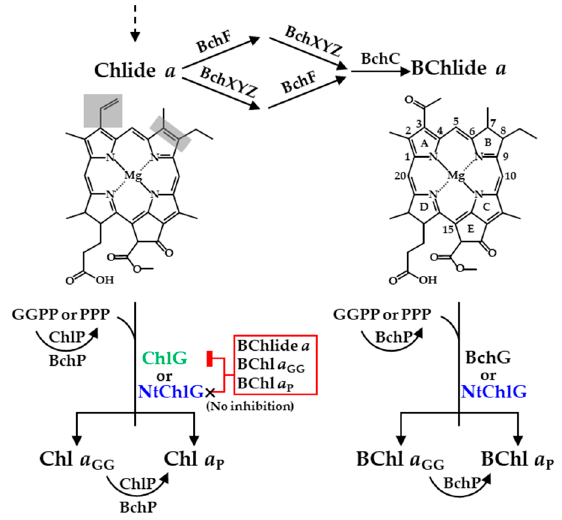
Figure 1. Chl a and BChl a biosynthesis in R. sphaeroides . Chlide a is metabolized by BchF and BchXYZ, and subsequently by BchC to form BChlide a . BChl a GG is synthesized via the ping-pong mode by BchG using GGPP and BChlide a as the first and second substrates, respectively. The GG group of BChl a GG is then reduced by BchP to yield BChl a P . Alternatively, PPP is first formed from GGPP by BchP and subsequently used as a substrate by BchG to produce BChl a P . Similarly, Chl a GG /Chl a P are synthesized by ChlG/ChlP. ChlP activity can be substituted by BchP [8] . Generally, ChlG would be inhibited by BChlide a , BChl a GG , and BChl a P (bacteriochlorin) (red box). Similarly, BchG would be inhibited by Chlide a , Chl a GG , and Chl a P (collectively called chlorin). However, this study focused on the analysis of recombinant R. sphaeroides synthesizing more BChl a than Chl a ; therefore, BchG inhibition by chlorin was negligible. Nicotiana tabacum ChlG (NtChlG), which is resistant to bacteriochlorin inhibition, was used to produce Chl a P together with BChl a P in R. sphaeroides . Carbon numbers and ring designations are illustrated in the BChlide a structure. Differences between Chlide a and BChlide a are denoted by shades in the Chlide a structure.